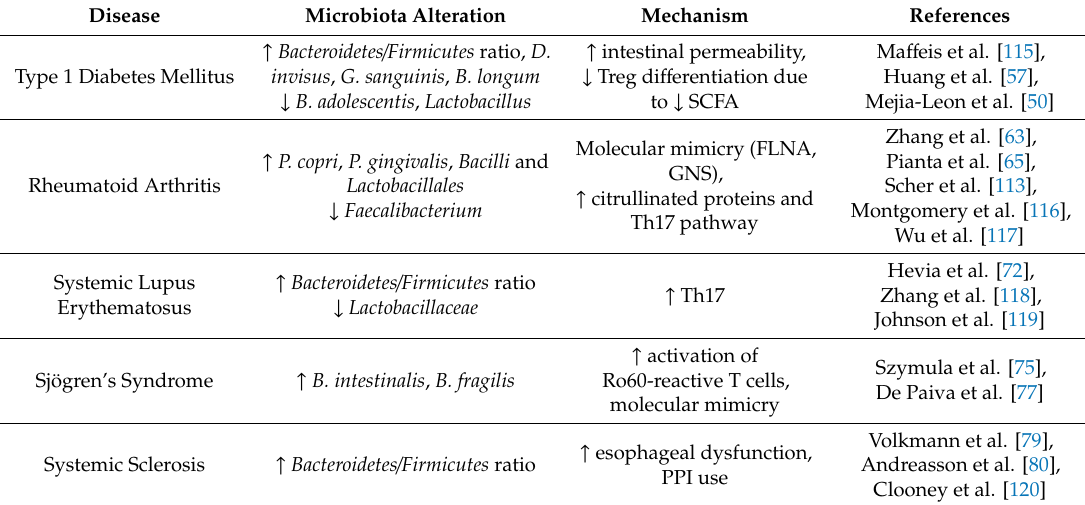
Table 1. Main alterations of gut microbiota and underlying pathogenetic